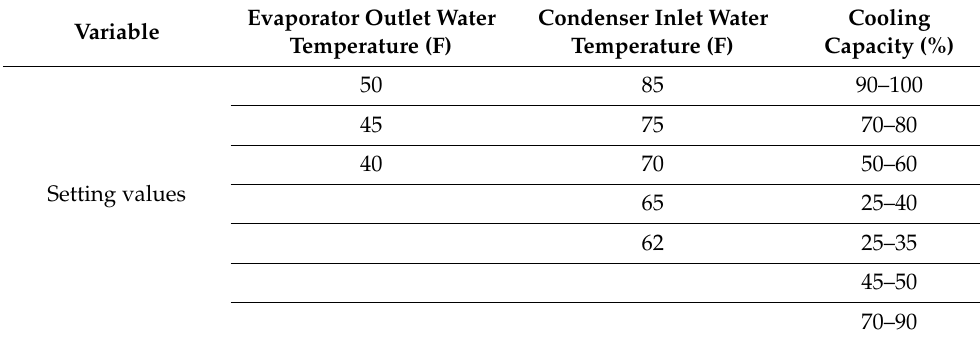
Table 1. Setting values of control parameters under three operating conditions.